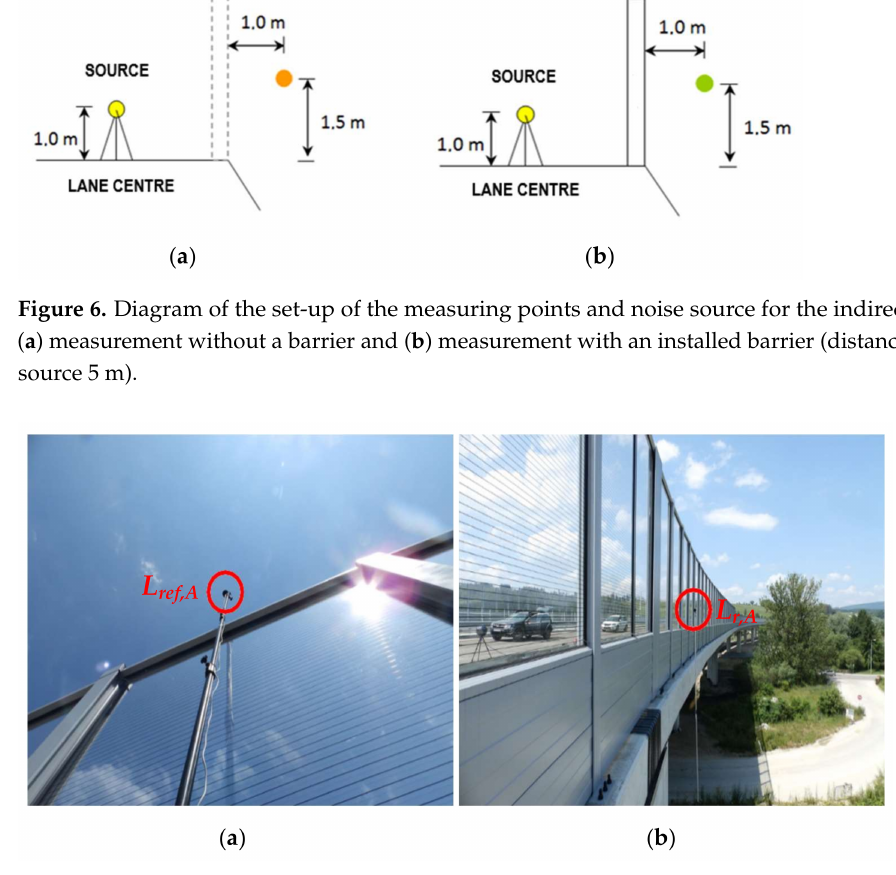
Figure 7. Measurement of the noise barrier insertion loss SO 241-00: ( a ) location of the microphone above the barrier L ref,A and ( b ) location of the microphone at the reception point L r,A . L ref , B —sound pressure level at the reference point without the barrier, microphone located at a height of 1.5 m above the level of the barrier, at an equivalent point with the place of installation of the